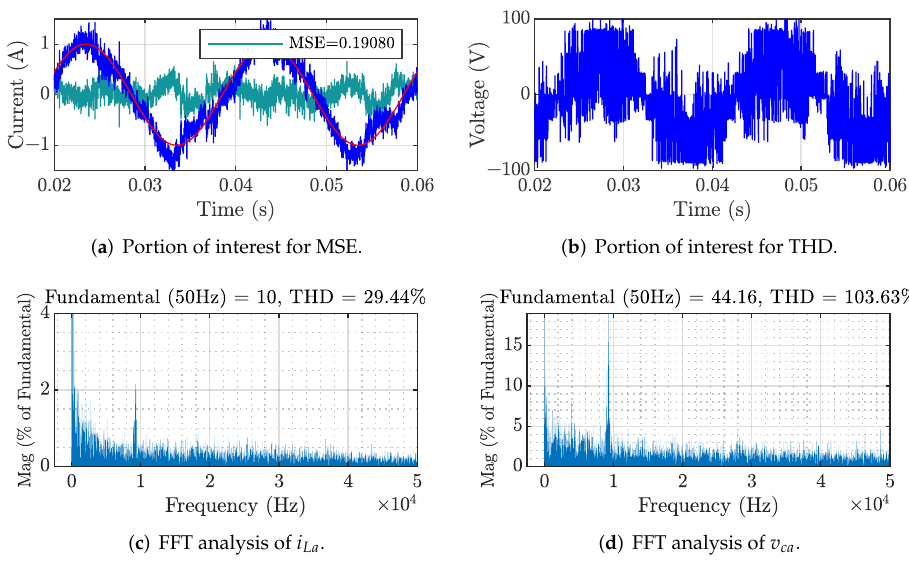
Figure 12. Experimental results for phase a in the presence of parametric uncertainties.